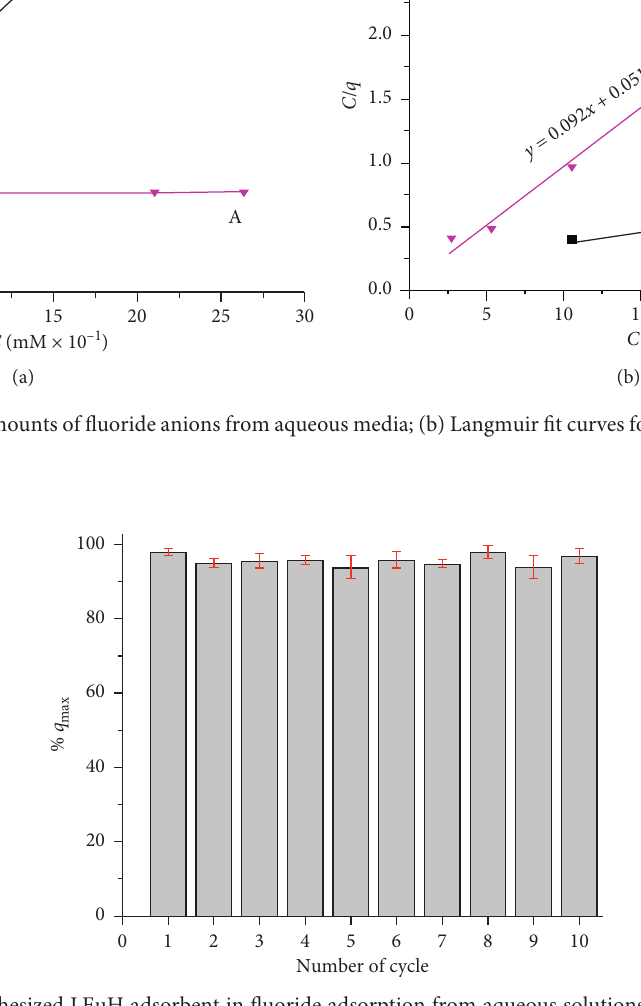
� 7; max � 40 mmol/g; pH